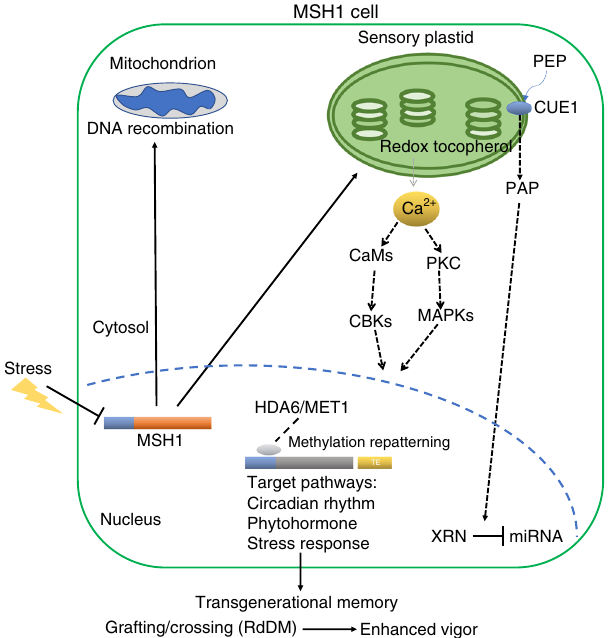
Fig. 9 A simpli fi ed model of MSH1-associated phenotypic plasticity. Stress-associated suppression of MSH1 expression alters conditions within the sensory plastid of epidermal and vascular parenchyma cells 20,58 . These changes involve at least two retrograde signaling pathways to the nucleus, one including redox and calcium signaling 20 and the other tocopherol- mediated modulation of the PAP phosphonucleotide as a mediator of miRNA regulation 58,77 . Nuclear response to sensory plastid perturbation is dependent on HDA6 and MET1 and includes genome-wide cytosine methylation repatterning and altered expression of integrated stress response networks. Speci fi city factors (gray oval) have been identi fi ed that associate with, and recruit, HDA6 to target loci that participate in the MSH1 effect 45 . The heritability of this repatterning may be in fl uenced by proximity of TEs to the target loci and the nature of HDA6 activity. Transgenerational memory induced by MSH1 suppression gives rise, through crossing or grafting, to progeny with markedly enhanced growth vigor and resilience phenotypes 15,17,59,60 . Gene promoters are shown as blue bars; target genes are shown by generic gray bar. Solid lines re fl ect data shown by our group; dashed lines re fl ect data published by other groups that are consistent with MSH1 data (past and present). This fi gure was created by the